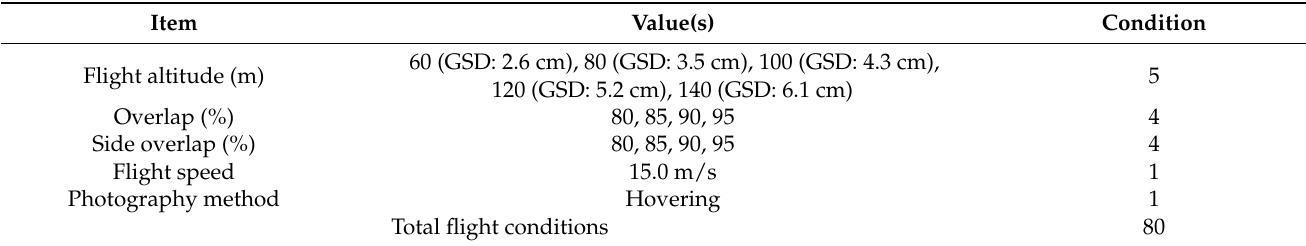
Table 1. Flight conditions and aerial imaging conditions for the